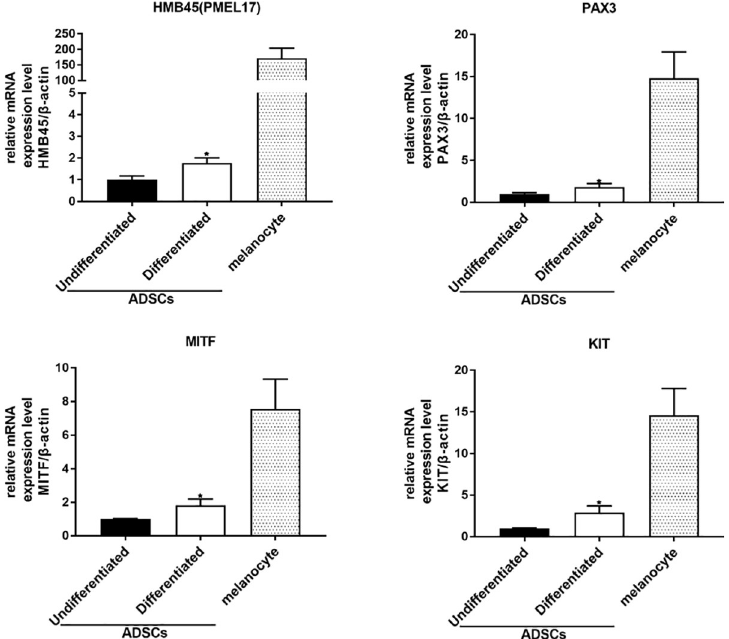
Fig 2. The expression of melanocytic markers in undifferentiated and differentiated ADSCs detected by RT-PCR. The expression levels of HMB45, MITF, PAX3, and KIT in undifferentiated ADSCs and differentiated ADSCs were compared with those in melanocytes by RT-PCR. The expression levels of HMB45, MITF, PAX3, and KIT were higher in differentiated ADSCs than in undifferentiated ADSCs.